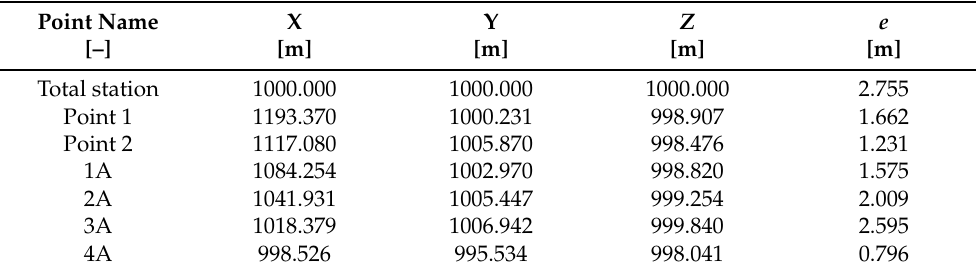
Table 1. The coordinate of the GCPs, the common points Point 1 and 2 and the shoreline are reported in the local reference